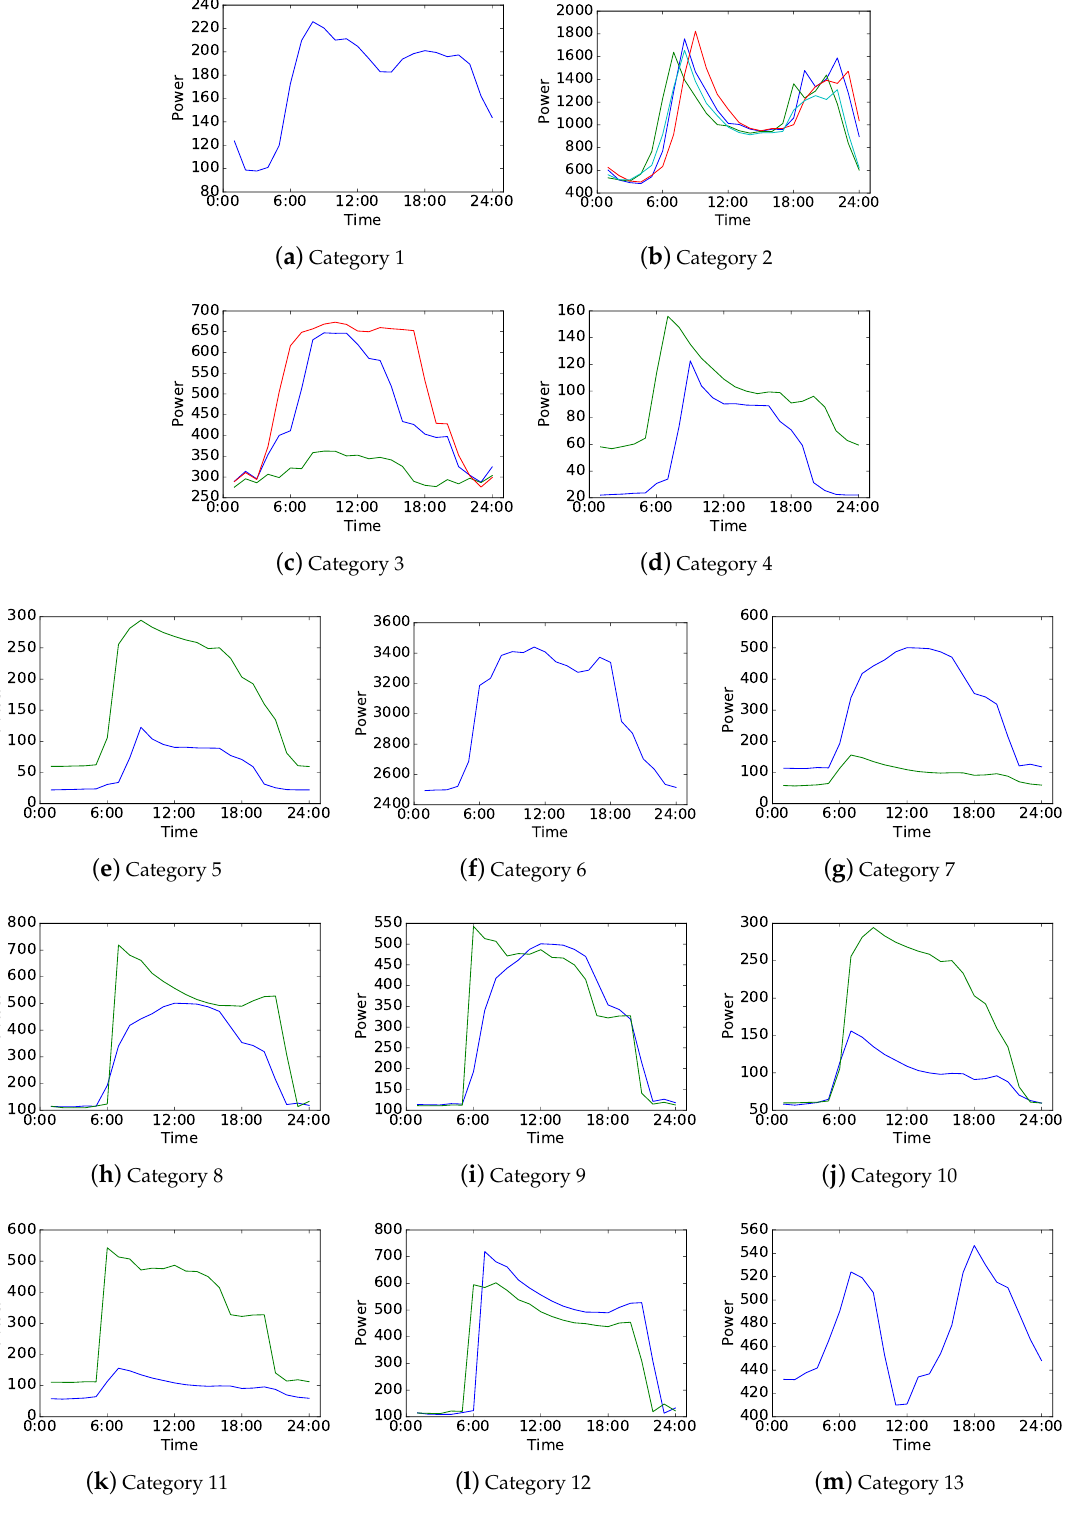
Figure 6. Thirteen electricity consumer characteristics identified from the load pattern clustering result shown in Figure 5 when λ = 0.032 . The characteristic shown in each subfigure stands for a consumer